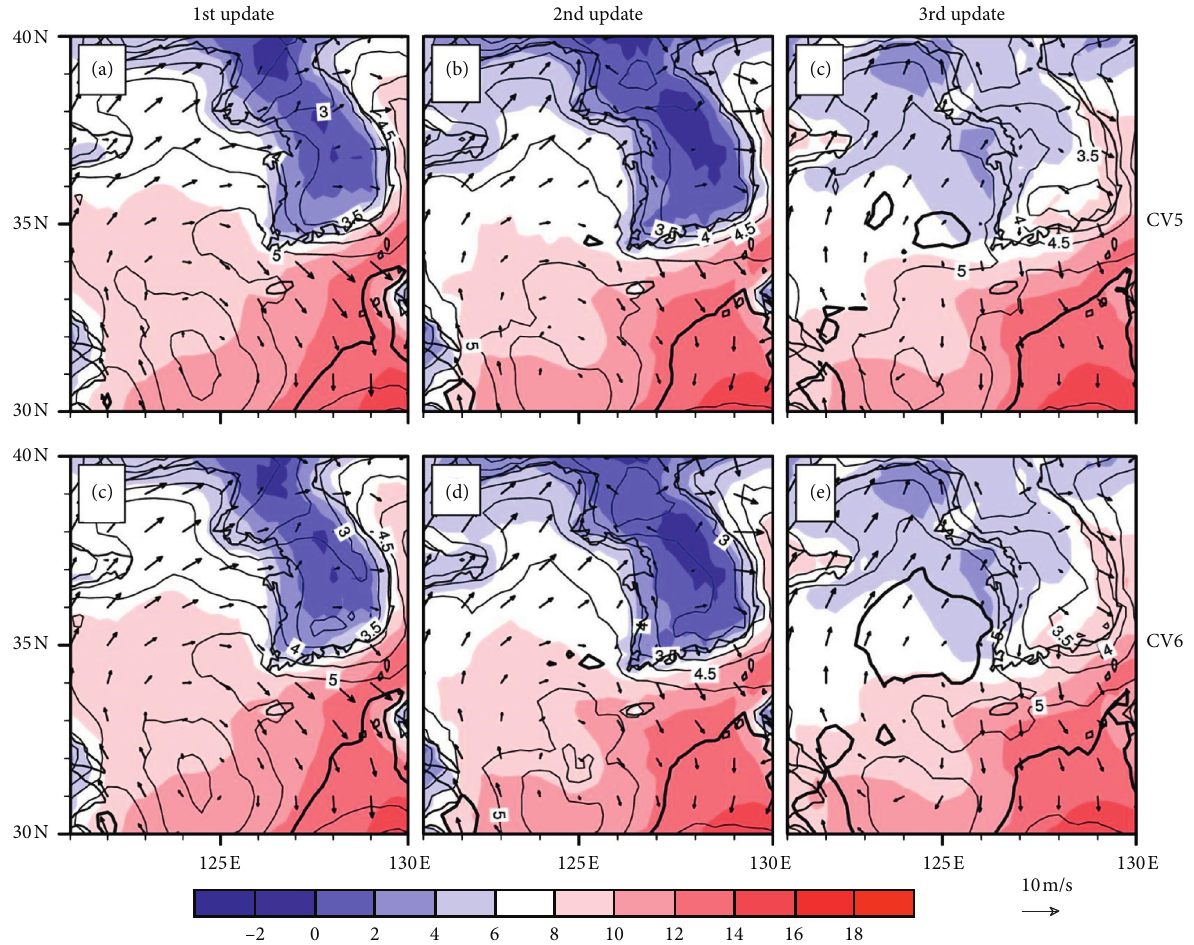
Figure 10: Analysis fields of temperature (color shades), wind (vectors), and mixing ratio (contours) at the lowest model level after three DA updates: (a)–(c) for CV5 and (d)–(f) for CV6. The bold lines indicate mixing ratio of